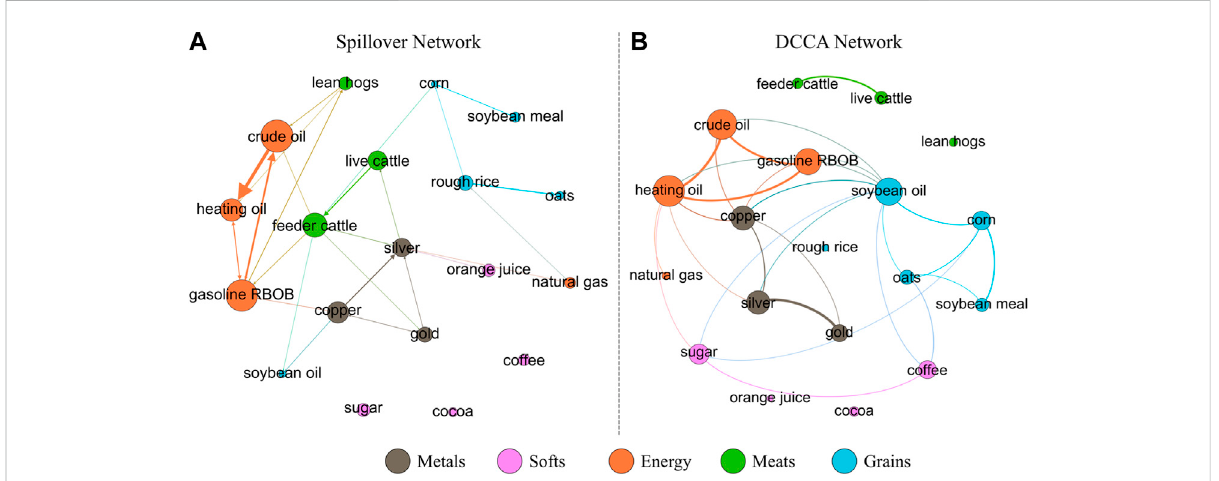
FIGURE 1 Volatility spillover network (A) and DCCA network (B) of 19 commodity futures. The links in the spillover network are directed, and only those with a weight of ~ π ij > 0 . 15 are displayed. The links in the DCCA network are undirected, and all the links with w ij > 0 . 2 are displayed. The node size in both networks is proportional to the degree (out-degree for the spillover network).